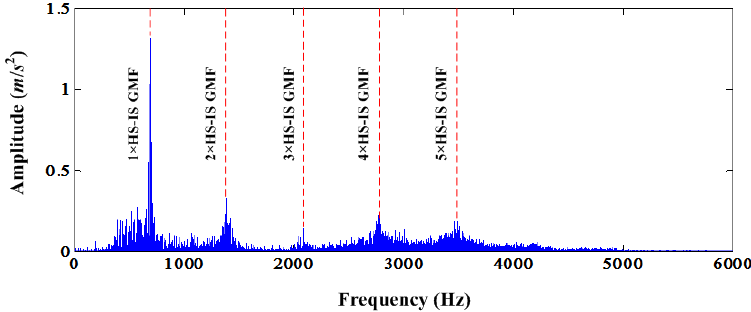
Figure 13. Frequency spectrum of the time synchronous signal; GMF, gear meshing frequency.